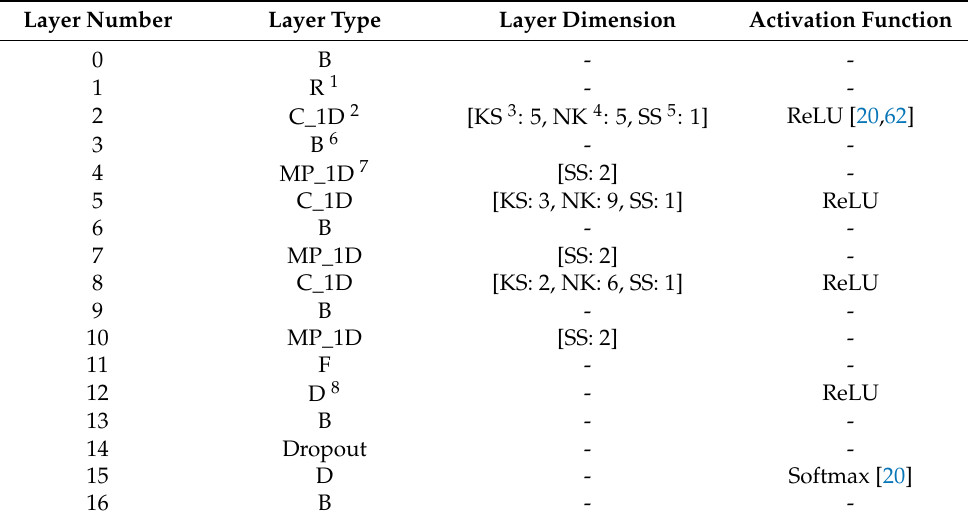
Table 3. Detailed structure of designed CNN for separate signals recognition depending on the examined parameters (PRI, PD, TW).